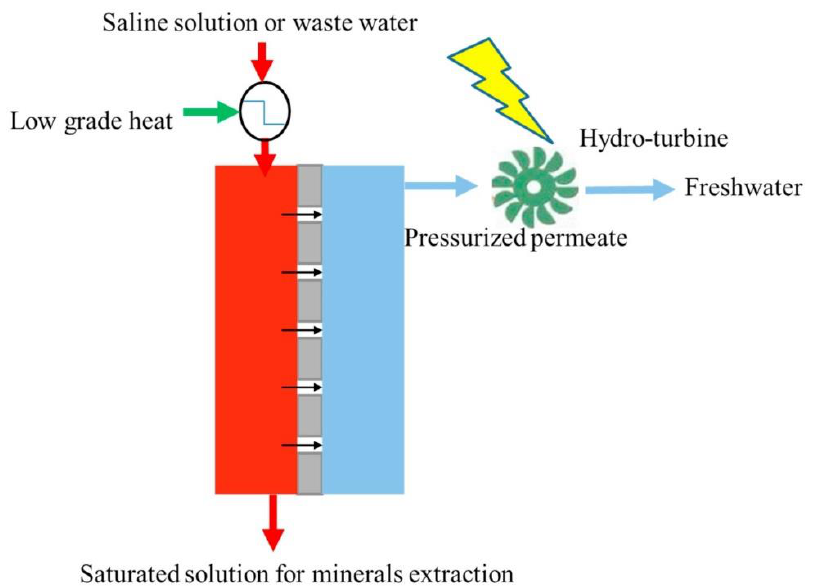
Figure 3. The concept of simultaneous production of freshwater, energy and raw materials through MD. Reproduced with permission from [19]. Copyright Elsevier, 2018.